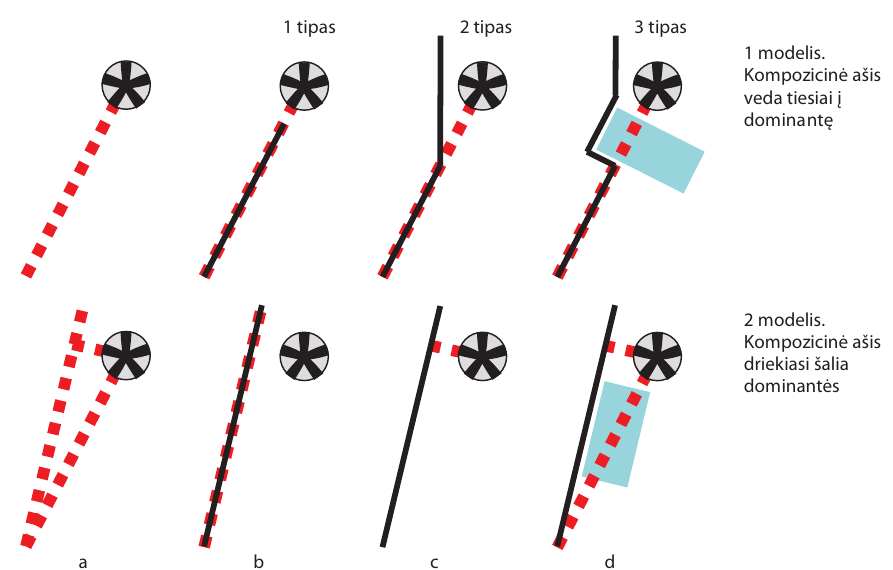
fig. 1. Interrelationship between compositional axes and dominant buildings: a – dominant building and appropriate visual connections; b – dominant building and visual connections, which overlap with compositional axis; c – dominant building and visual connections, which partially overlap with compositional axis, when visibility is not obstructed by visual barriers; d – dominant building and visual connections, which partially overlap with compositional axis, when visibility is not obstructed by natural